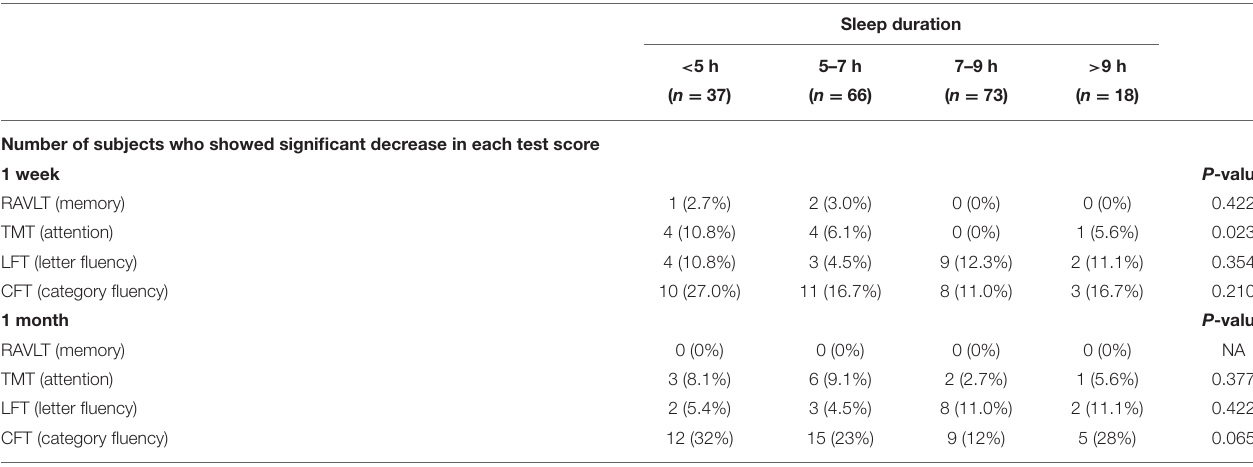
TABLE 4 | Prevalence of a significant decrease in each test score ( > 1 SD from the